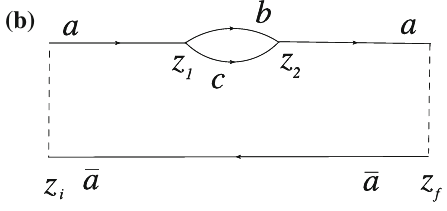
Fig. 1 a Diagram representation for the spectrum of the particle b for the a → bc process. b Diagram representation for the radiative correction to the spectrum of the particle a from the virtual process